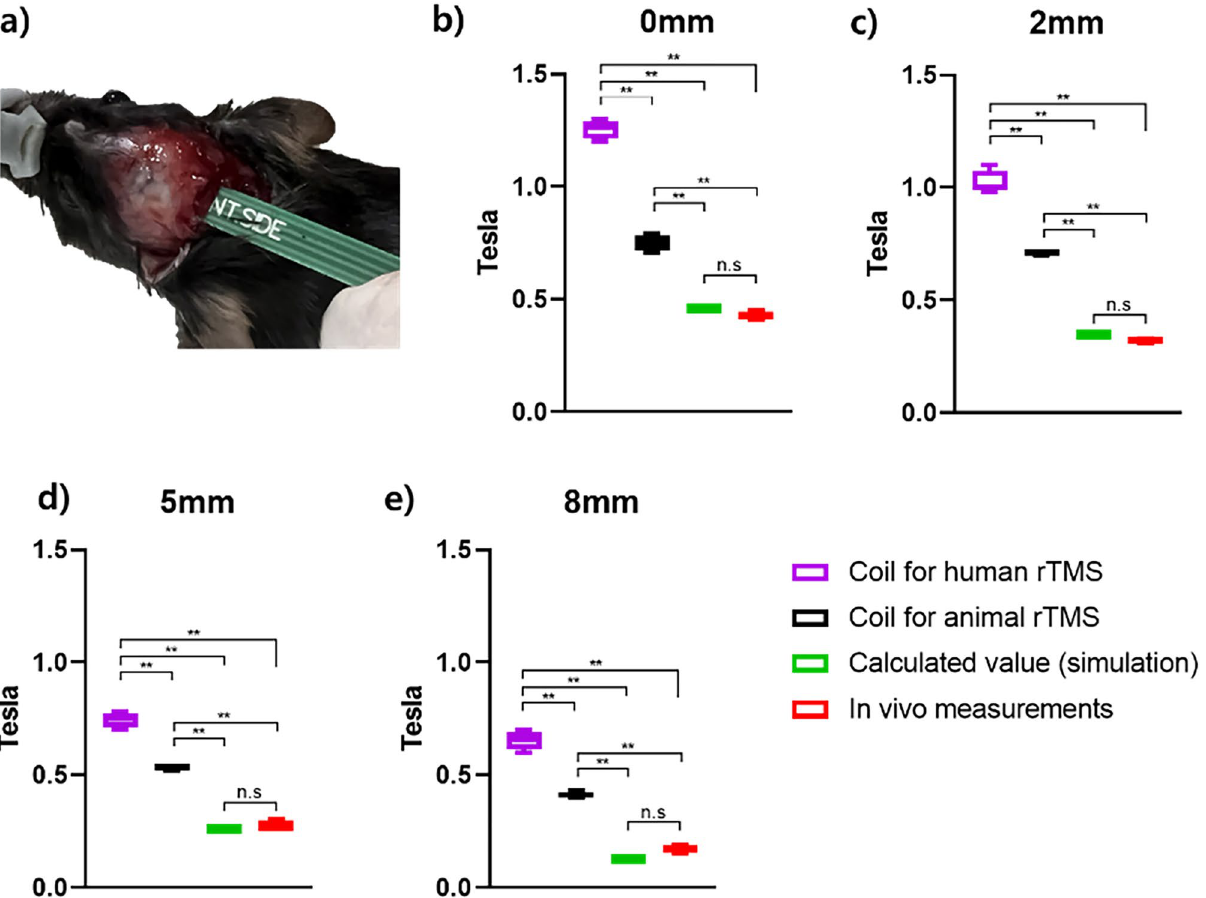
Figure 15. Prediction of magnetic field by repetitive transcranial magnetic stimulation (rTMS) type and measurement of magnetic fields in vivo : ( a ) in vivo experimental setup with the Tesla meter comparing the human coil, murine coil, simulation results, and experiment results with changes in distance between coil and head of: ( b ) 0 mm; ( c ) 2 mm; ( d ) 5 mm; and ( e ) 8 mm. Levels of significance for comparison by one-way ANOVA test: **p < 0.01, n.s, not significant. p = 0.448, 0 mm n.s; p = 0.518, 2 mm n.s; p = 0.8327, 5 mm n.s; p = 0.0509, 8 mm